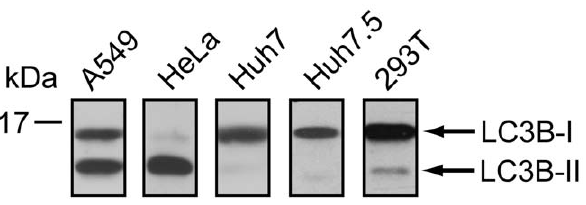
Figure 1. LC3B levels in various human cell lines. Whole cell lysates prepared from A549, HeLa, Huh7, Huh7.5, or 293T cells were subjected to immunoblot analysis by using anti-LC3B. Protein molecular size standards (in kilodaltons) are indicated on the